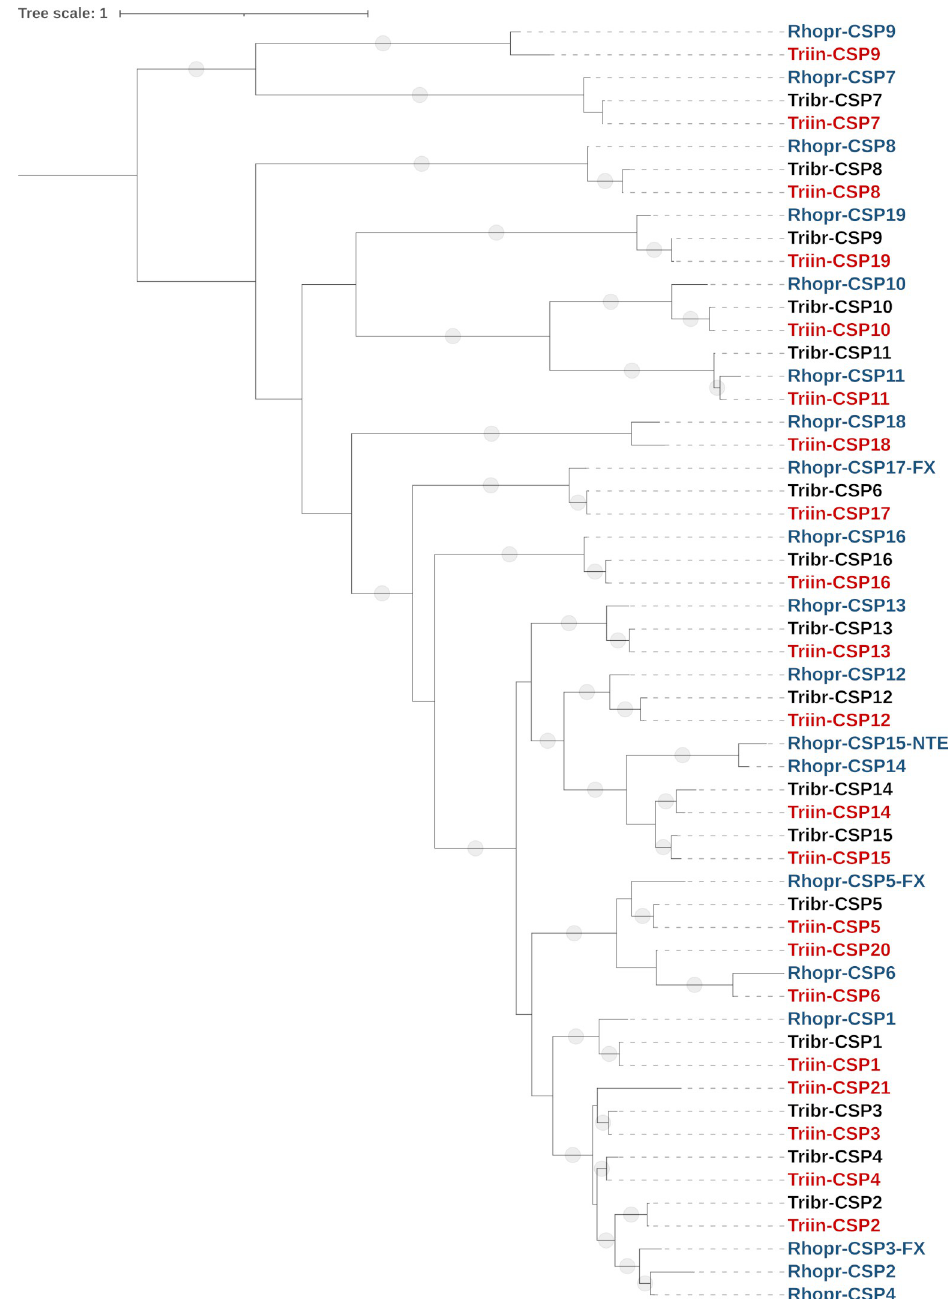
Fig 2. Phylogenetic tree of the CSP family from T . infestans , T . brasiliensis and R . prolixus . The maximum- likelihood tree was constructed using IQ-Tree and protein sequences obtained from the transcriptomes of T . infestans (Triin-, red, available in Table E in S2 File) and T . brasiliensis (Tribr-, black, obtained from [28], and from the R . prolixus genome (Rhopr-, blue, NTE: N-terminus missing in gap; FX: gene model repaired based on de novo transcriptome assemblies; obtained from [29]). Sequences from T . infestans were named according to their R . prolixus orthologues, with the exception of Triin-CSP20 and Triin-CSP21 which have no orthologues in R . prolixus . Branches with SH-aLRT support values > 80 are marked with a grey dot. The tree was rooted at midpoint.